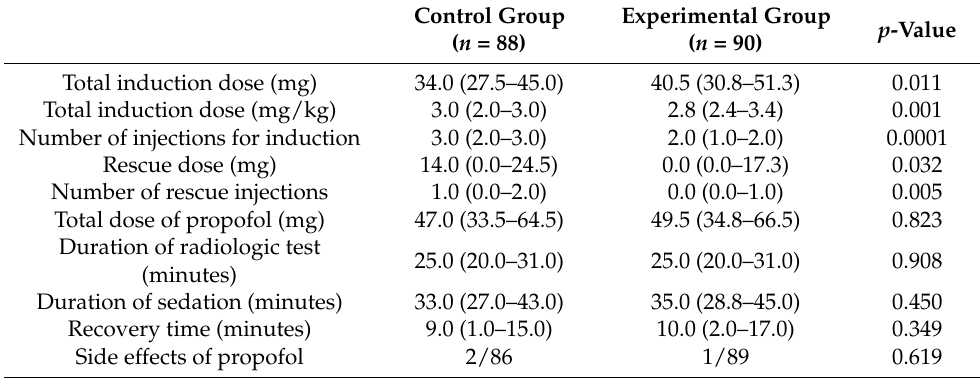
Table 3. Outcome measures of children undergoing sedation during the radiologic